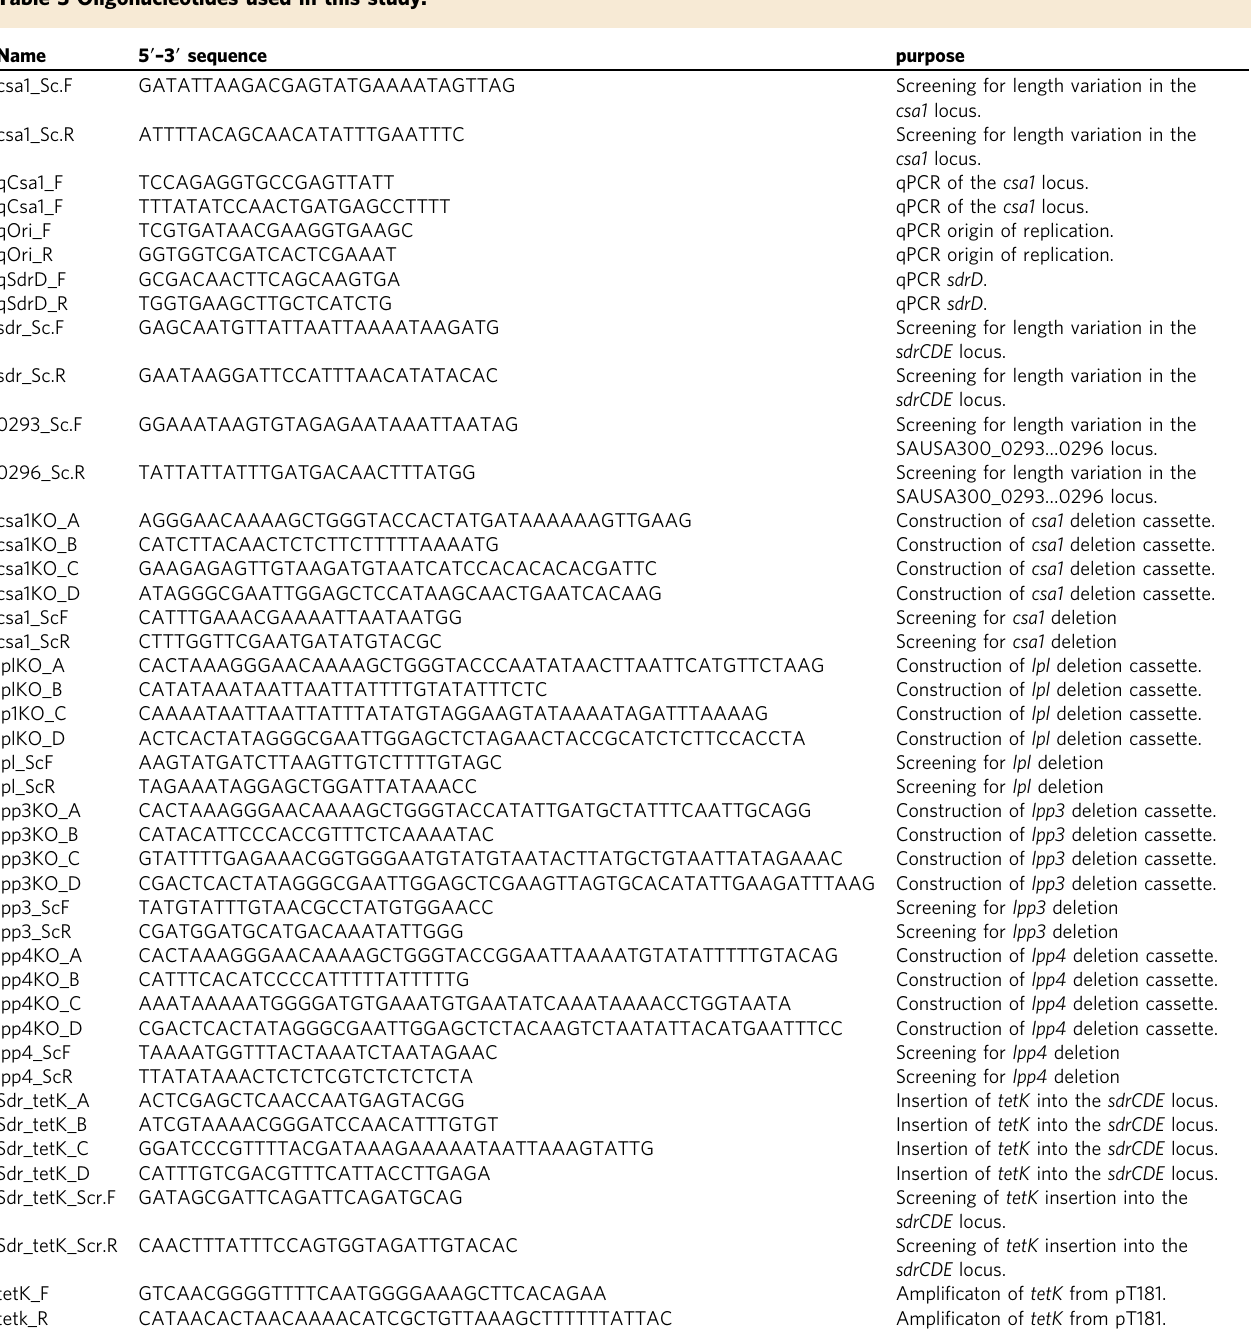
Table 3 Oligonucleotides used in this